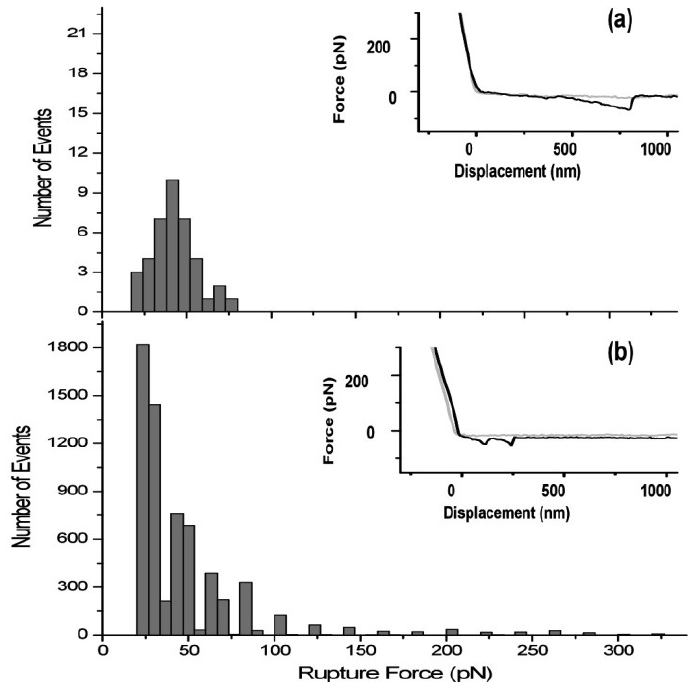
Figure 5. Histograms of rupture force between the AFM tip and living S. mutans wapA mutant ( a ) and wild type ( b ) cells. Insets show typical force-displacement curves revealing adhesive interactions between the cantilever tip and cell surface in the retract trace. In the case of S. mutans wild type cells (b), adhesion forces for the observed rupture events ranged from ≈ 20-330 pN. Those observed for the wapA mutant cells (a) had a range between ≈ 20-80 pN. The average rupture force for the wapA mutant and UA140 wild type cells is 43 ± 13 pN and 84 ± 156 pN, respectively. Reprinted in part with permission from [45]. Copyright 2007 Society for General